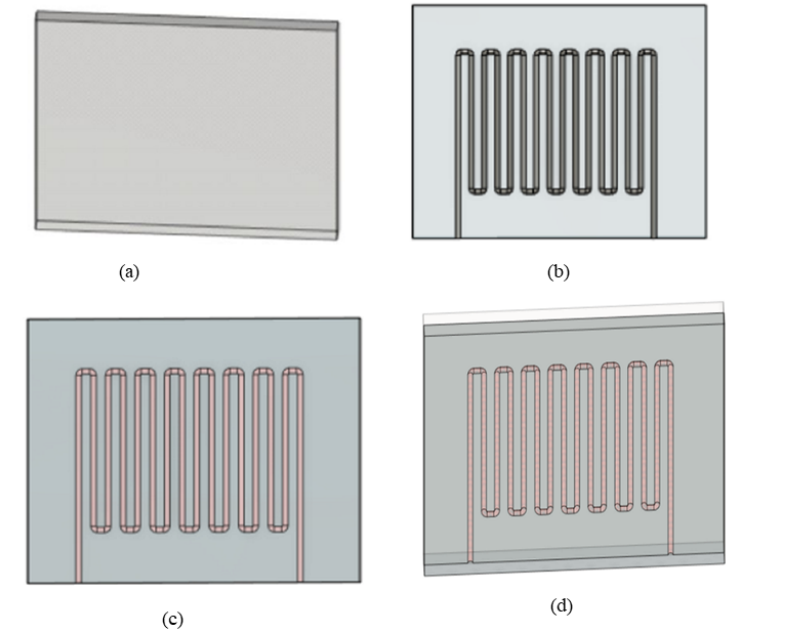
Figure 3. ( a ) Three-dimensional design layout of the soft sensor, ( b ) embedded microchan- nel, ( c ) schematic view of flexible sensor embedded with liquid metal (injection of Galinstan). ( d ) Schematic illustration of the sensor (Galinstan coating).